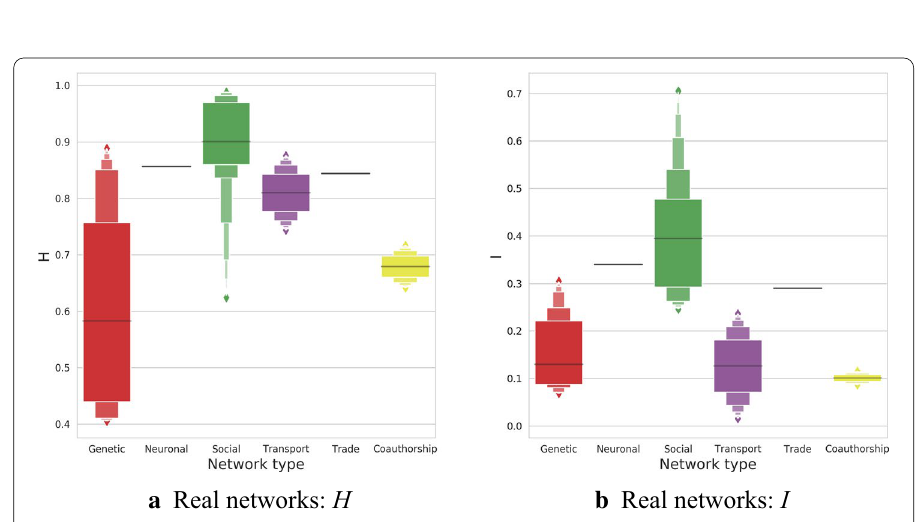
Fig. 13 Entanglement homogeneity and intensity compare for each category of networks, showing quite diverse set of properties proper to the different families of